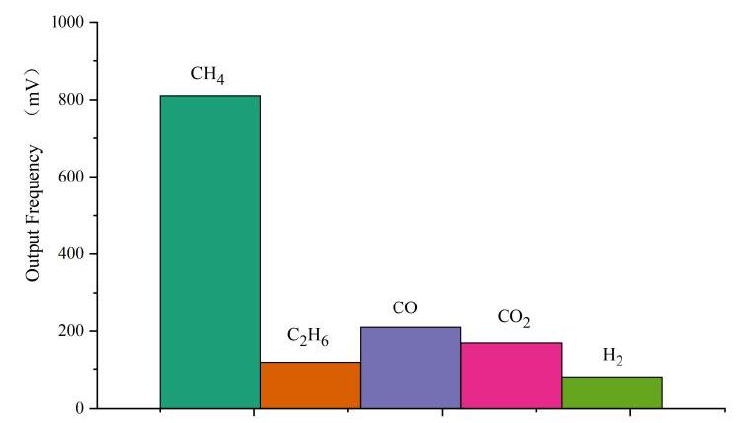
Figure 13. Methane sensor response–recovery time curve.